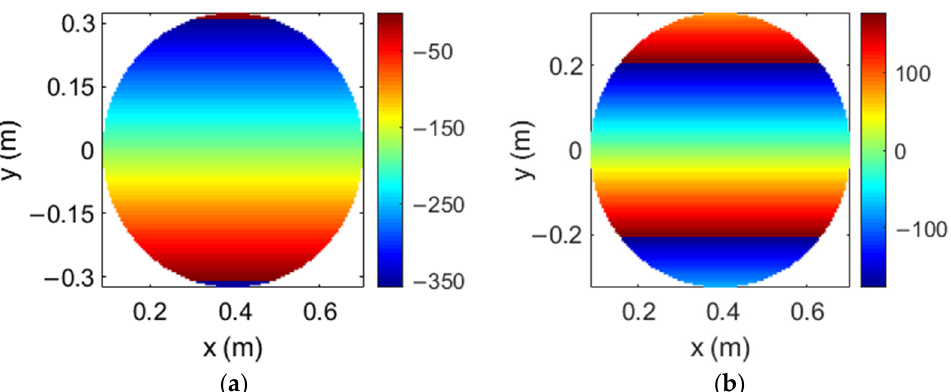
Figure 11. Required phase distributions of the 0.65 m flat subreflectarray at the ( a ) lower and ( b ) upper operating frequencies for the same linear polarization (LP).